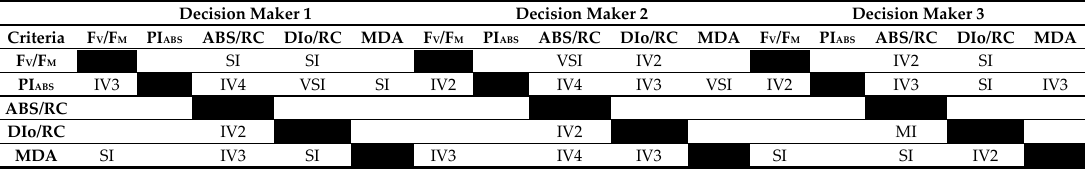
Table 5. Pairwise comparisons of decision makers concerning criteria of cold stress.